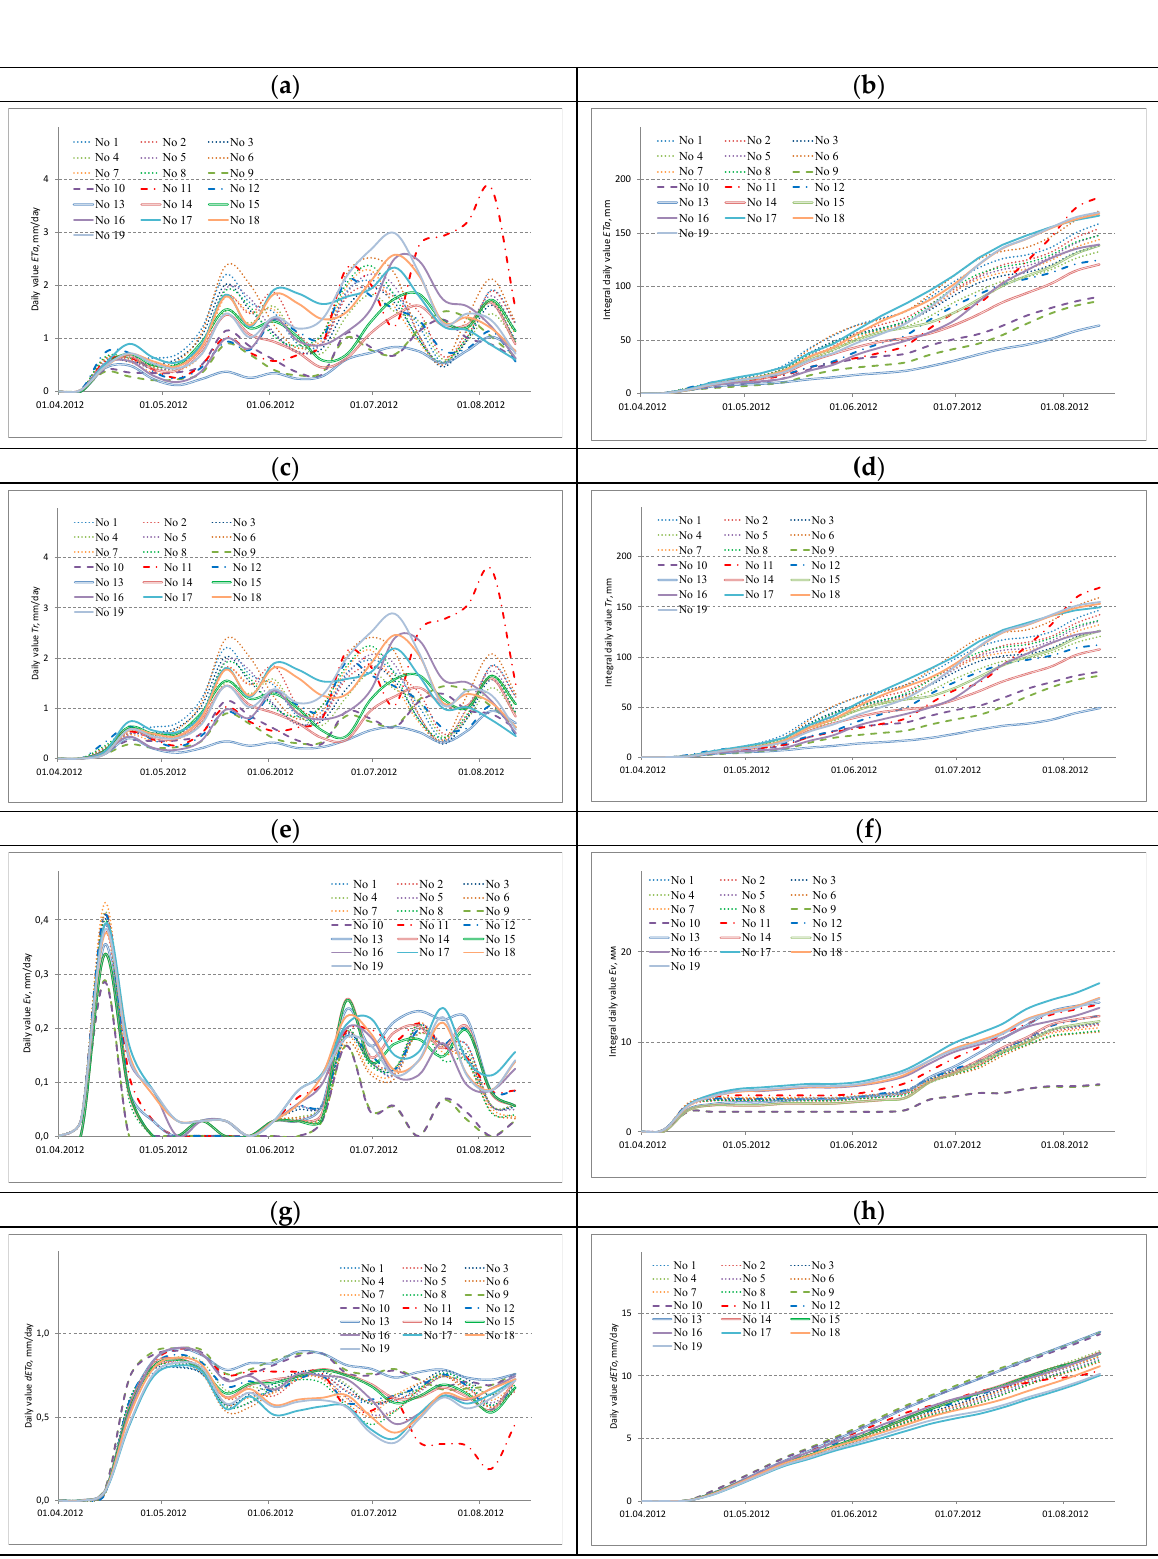
Figure 3. The time series of irrigated alfalfa crops calculated by the SEBAL model: ( a ) daily values of ETa ; ( b ) integral daily values of ETa ; ( c ) daily values of Tr ; ( d ) integral daily values of Tr ; ( e ) daily values of Ev ; ( f ) integral daily values of Ev ; ( g ) daily values of dETo ; ( h ) integral daily values of dETo . The 4 th wave, attributable to the period of late June and early July, is fairly